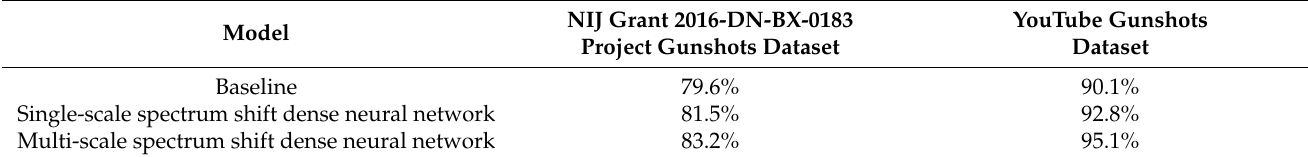
Table 4. Validation of spectrum displacement module.